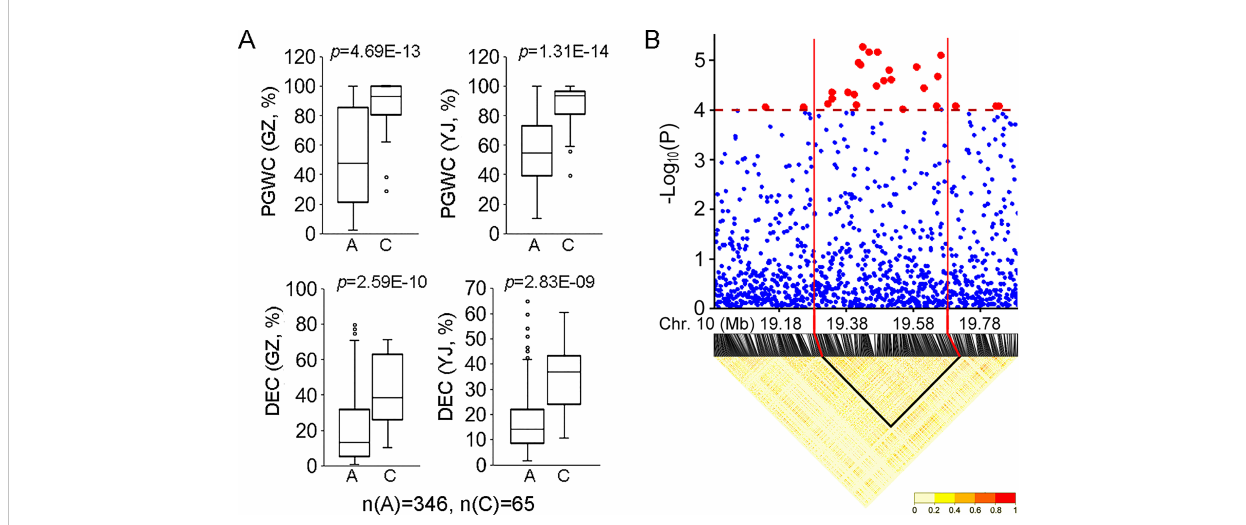
FIGURE 3 Phenotype and region analysis of qDEC-10c 1w,2wj . (A) Phenotypic comparison of PGWC and DEC between accessions with different haplotypes for qDEC-10c 1w,2wj . Statistical comparison was performed by one-side t-test. (B) Local manhattan plot of GWAS and linkage disequilibrium heatmap for qDEC-10c 1w,2wj .